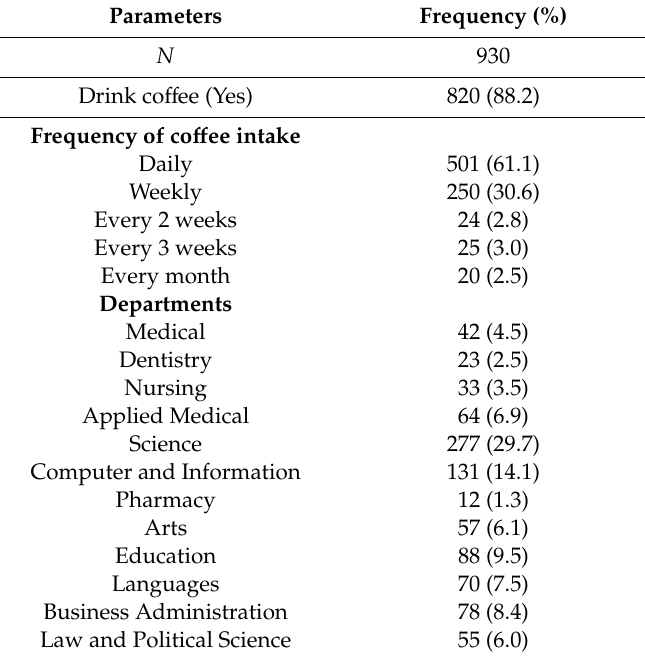
(Table 2). No significant statistical di ff erence was observed among co ff ee consumers vs. non-consumers related to their medical history. Table 1. Demographic characteristics of participants.